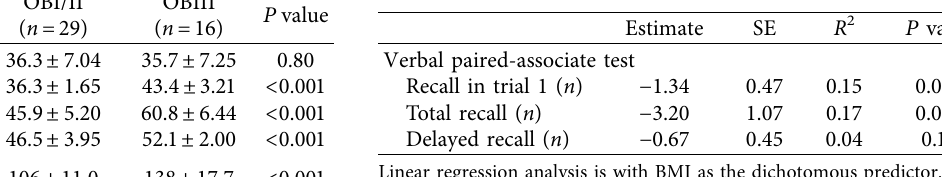
Table 3: Linear regression analysis between verbal paired-associate test and